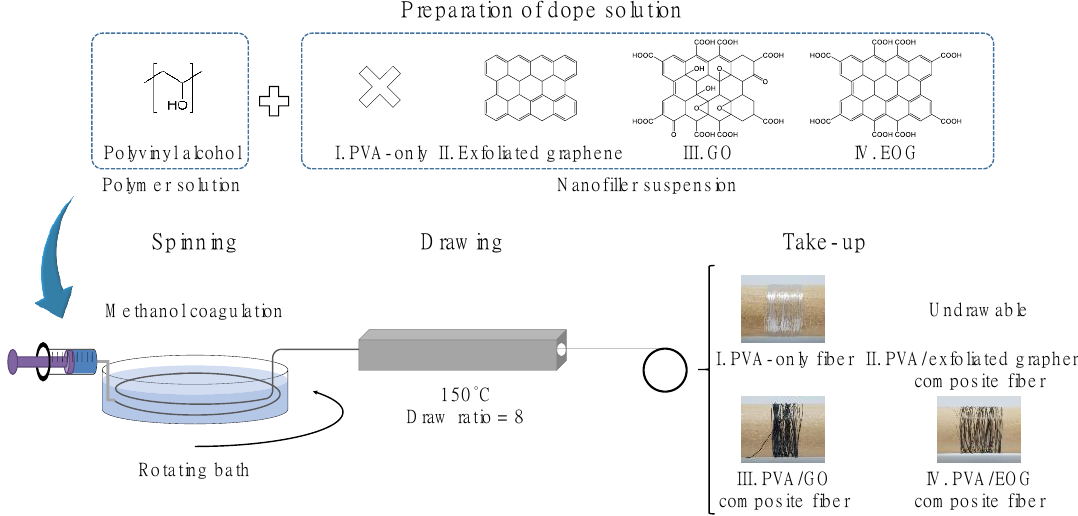
Figure 1. Schematic representation of the spinning dope solution preparation, spinning, and drawing processes carried out in this work.